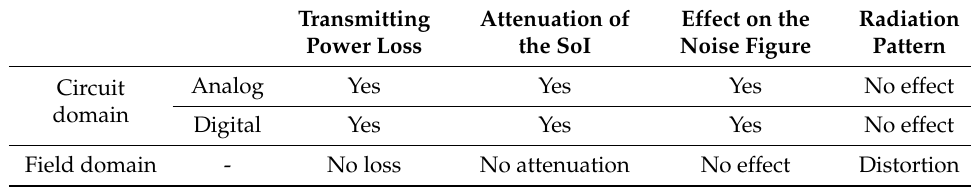
Table 2. Comparison of the circuit domain SIC and the field-domain